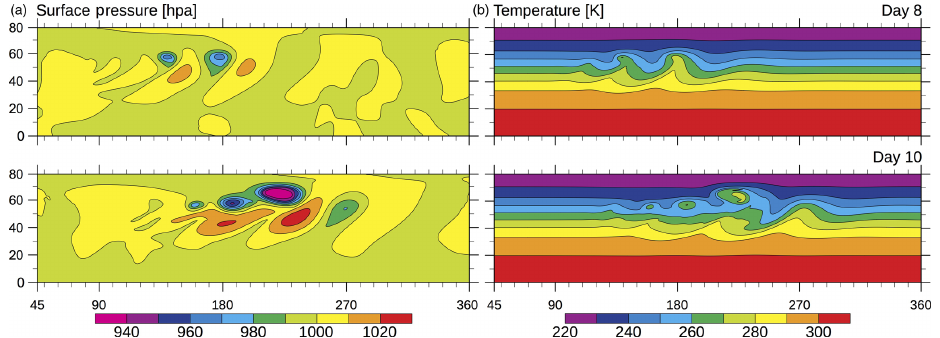
Figure 3. Evolution of a baroclinic wave in a dry simulation with 47km grid spacing on day 8 and 10: (a) surface pressure and (b) temperature on the 850hPa pressure level (roughly 1.5km above sea level).